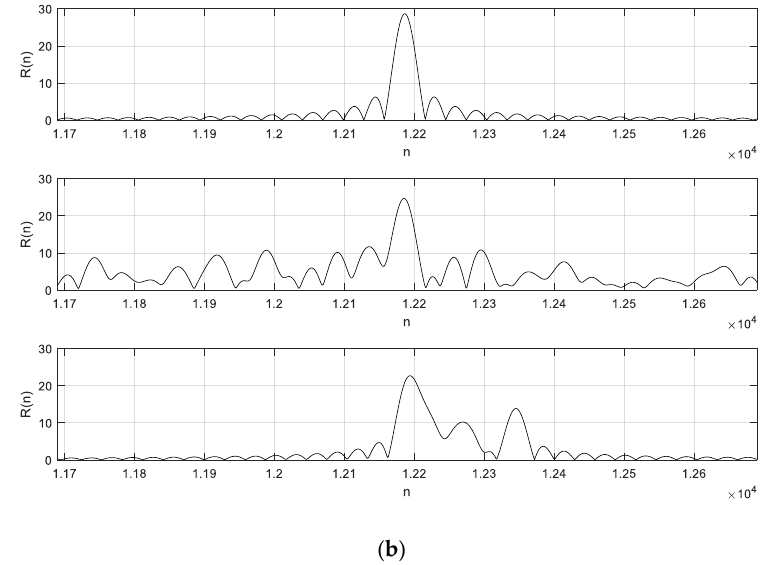
Figure 8. Preamble sequence correlation peak: ( a ) all points and ( b ) part of the points.